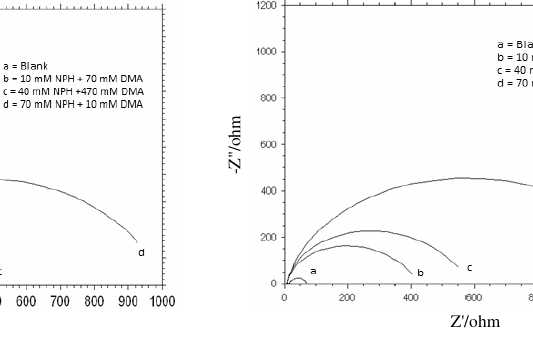
Figure 4. Electrochemical impedance plots Figure 5. Electrochemical impedance plots in absence and in presence of NPH + DMA in absence and in presence of NPH + EA Table 6. Electrochemical impedance parameters in absence and in presence of the binary inhibitor